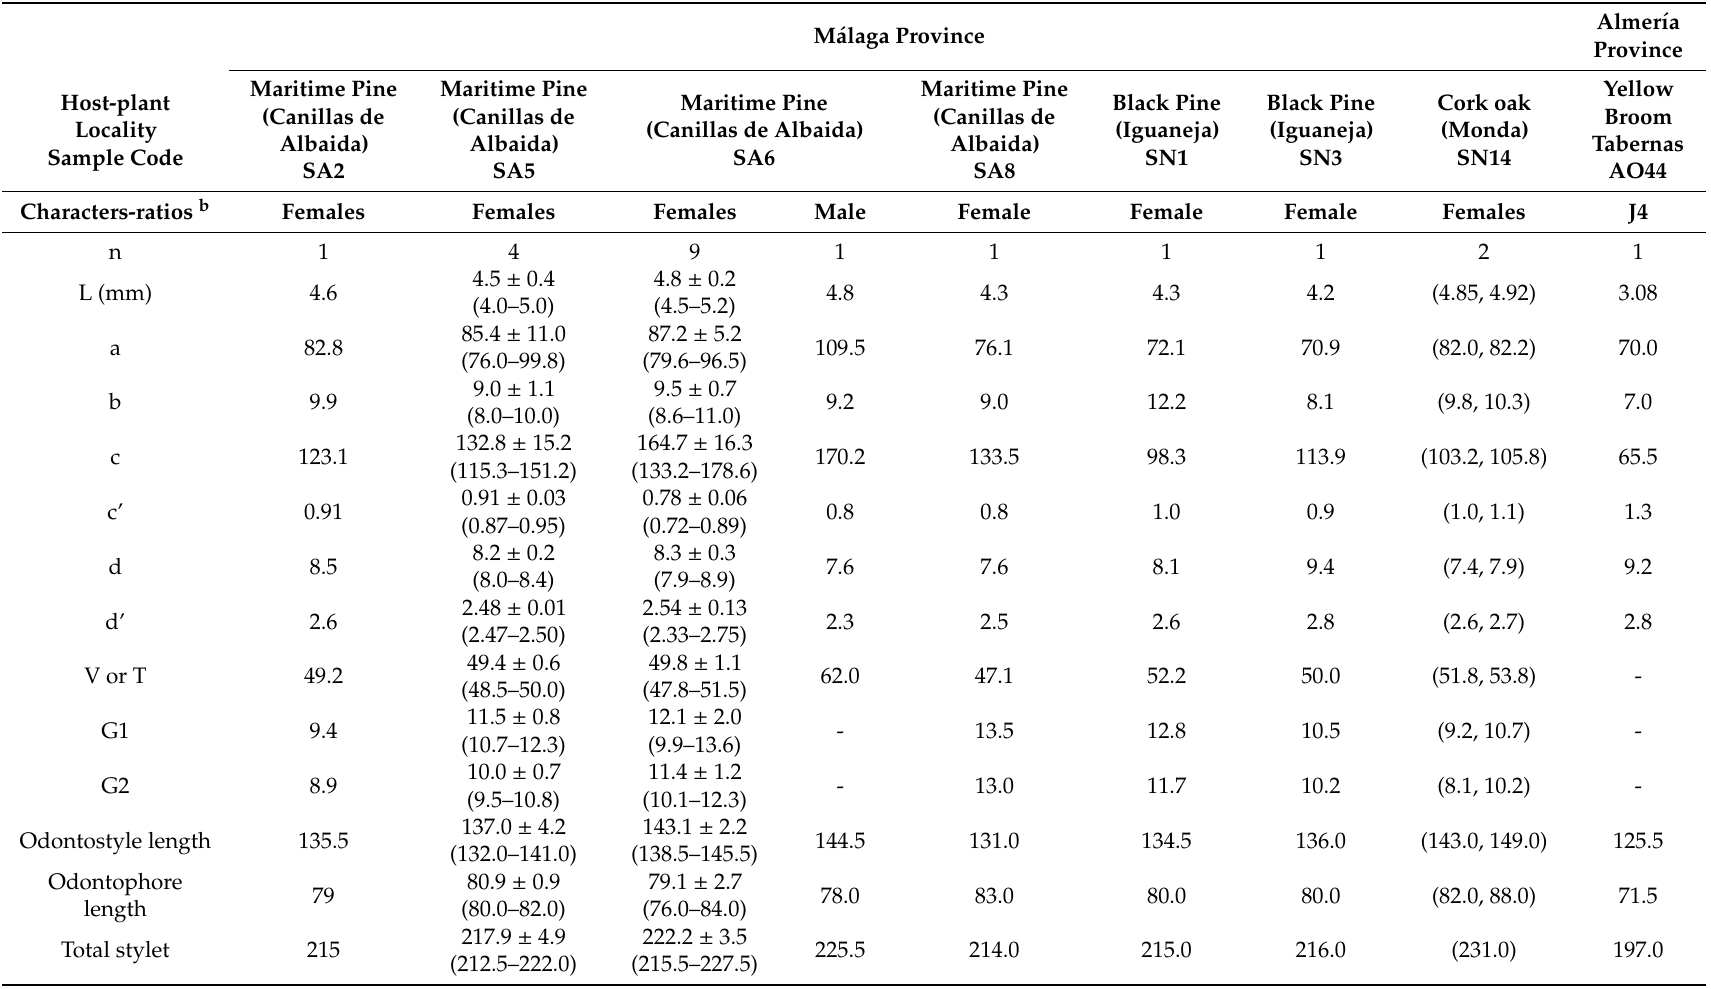
Table 4. Morphometrics of Xiphinema malaka sp. nov. from several sampling points and localities at M á laga and Almer í a provinces, southern Spain a